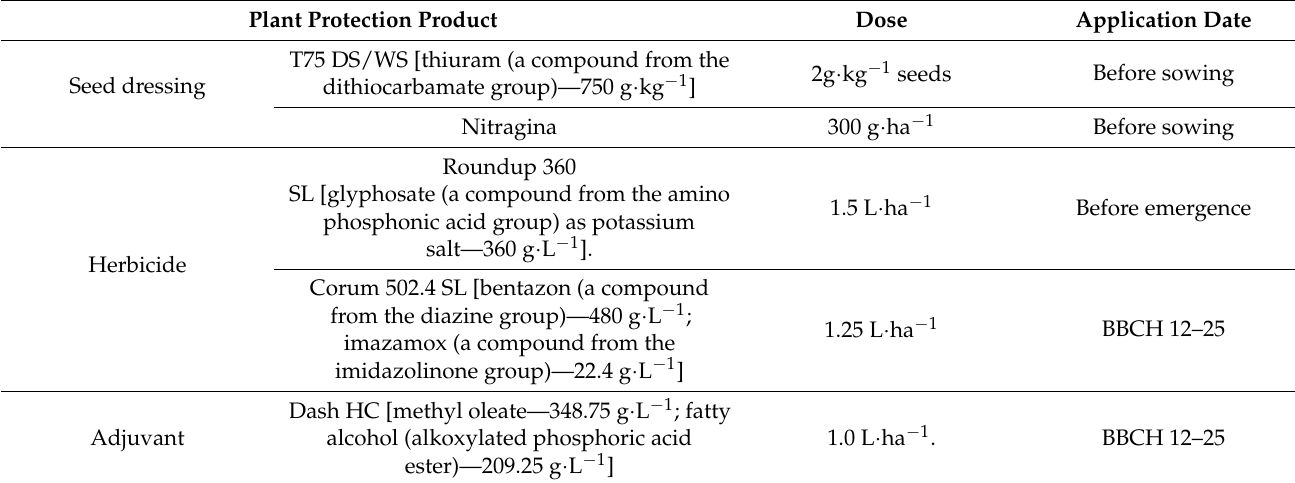
Table 2. Chemical plant protection of the soybean during the growing seasons. Plant Protection